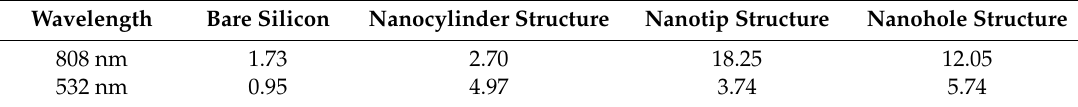
Table 2. The photocarrier concentrations ( × 10 24 · m − 3 ) of the four models at 60 mW / mm 2 . Wavelength